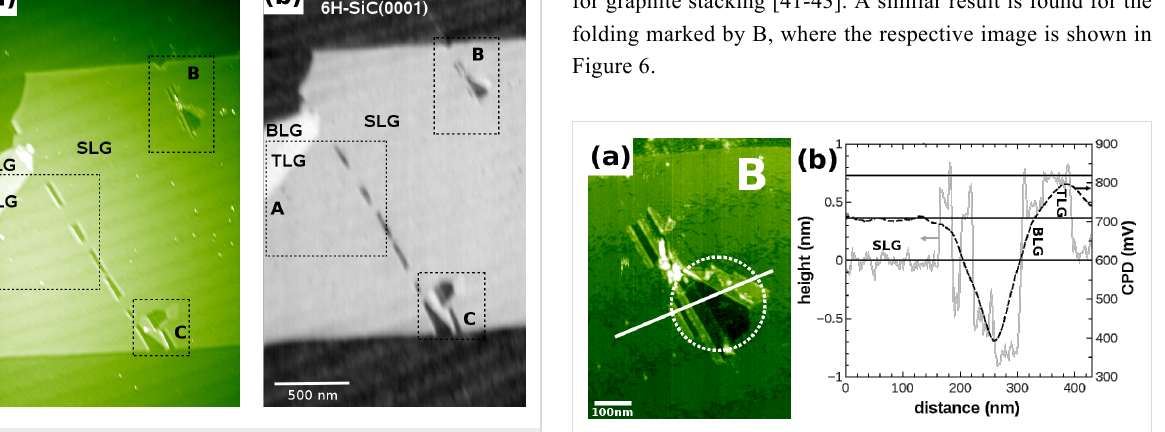
Figure 6: (a) NC-AFM image of the region marked by B in Figure 4, where post-preparation treatment resulted in the folding encircled by the dashed line. Line profiles (b) reveal the height (solid gray line) of BLG (limited accuracy due to areal size and spatial resolution) and TLG (+0.72 nm with respect to SLG) in agreement with the interlayer distance (marked by horizontal full lines) found for graphite stacking. From the LCPD line profile (dashed black line), the LCPD of the different foldings can not be discriminated due to the limited spatial